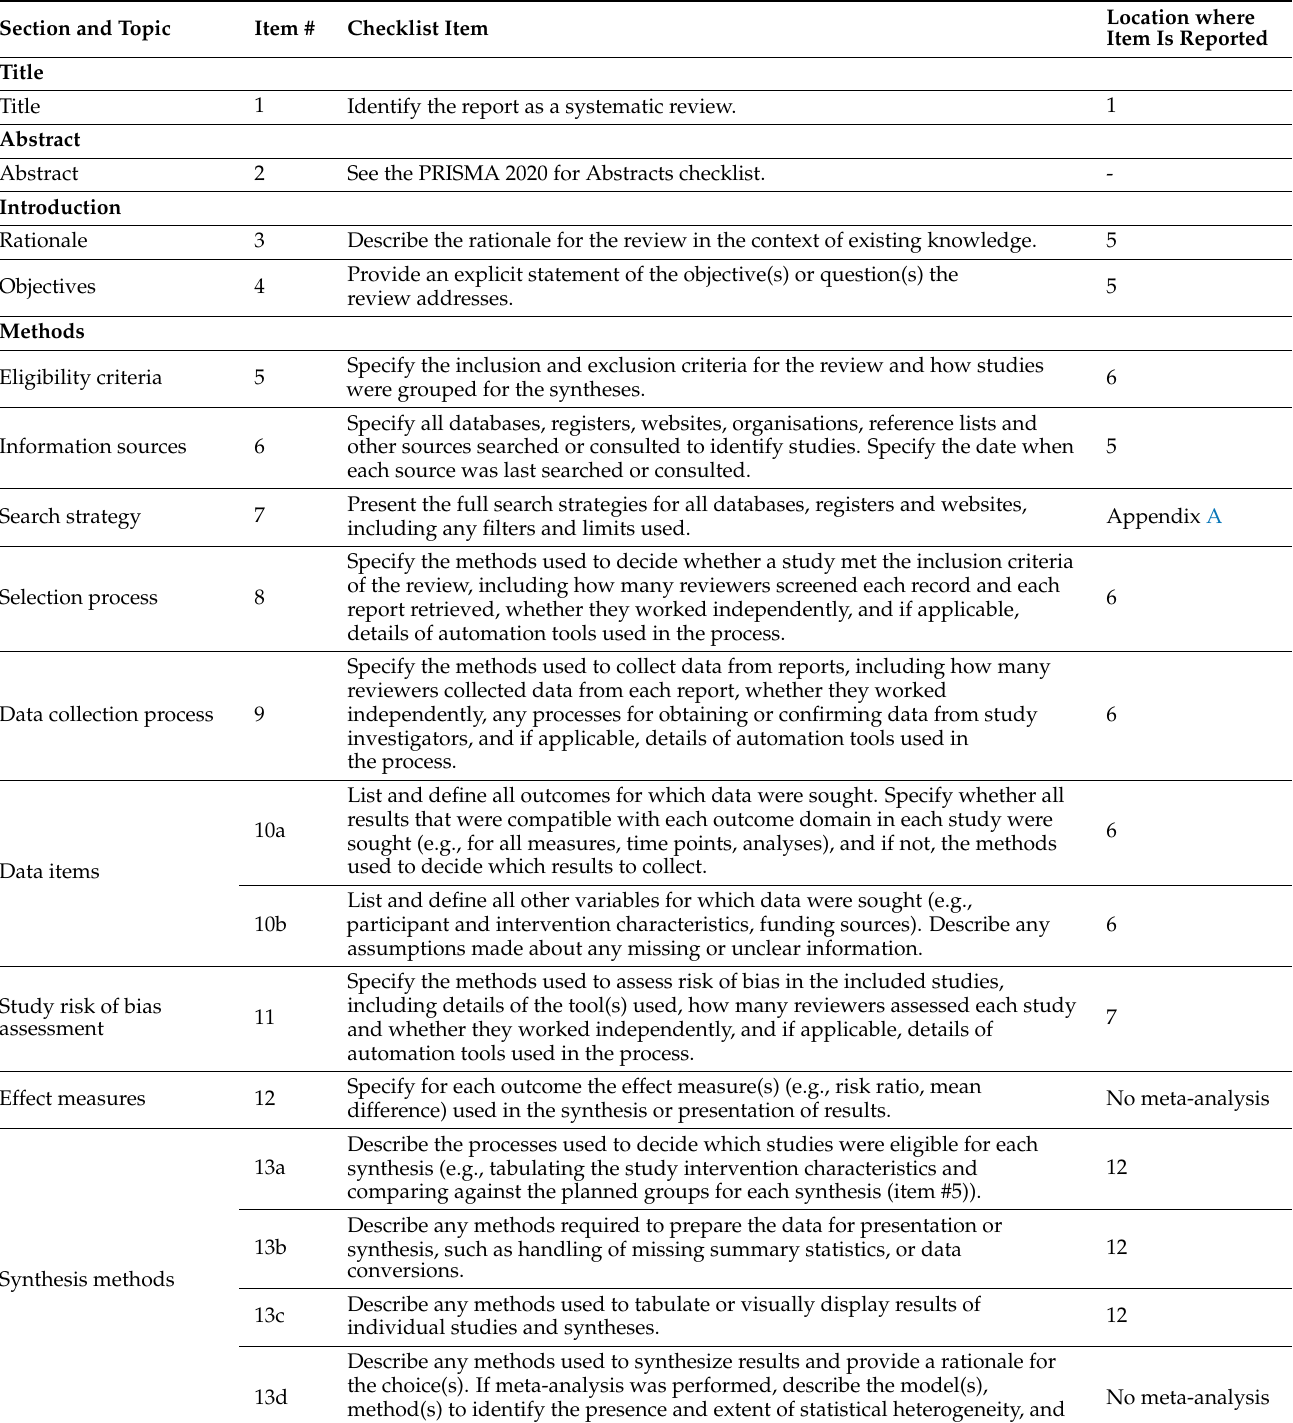
Table A3. PRISMA 2020 Checklist [17]. Checklist indicating the location of the PRISMA